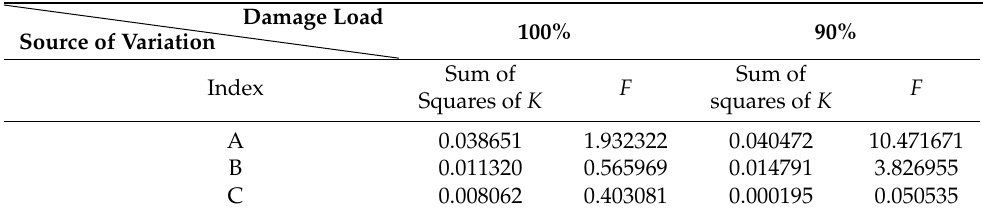
Table 12. Ultrasonic sound speed recovery rate (age of 28